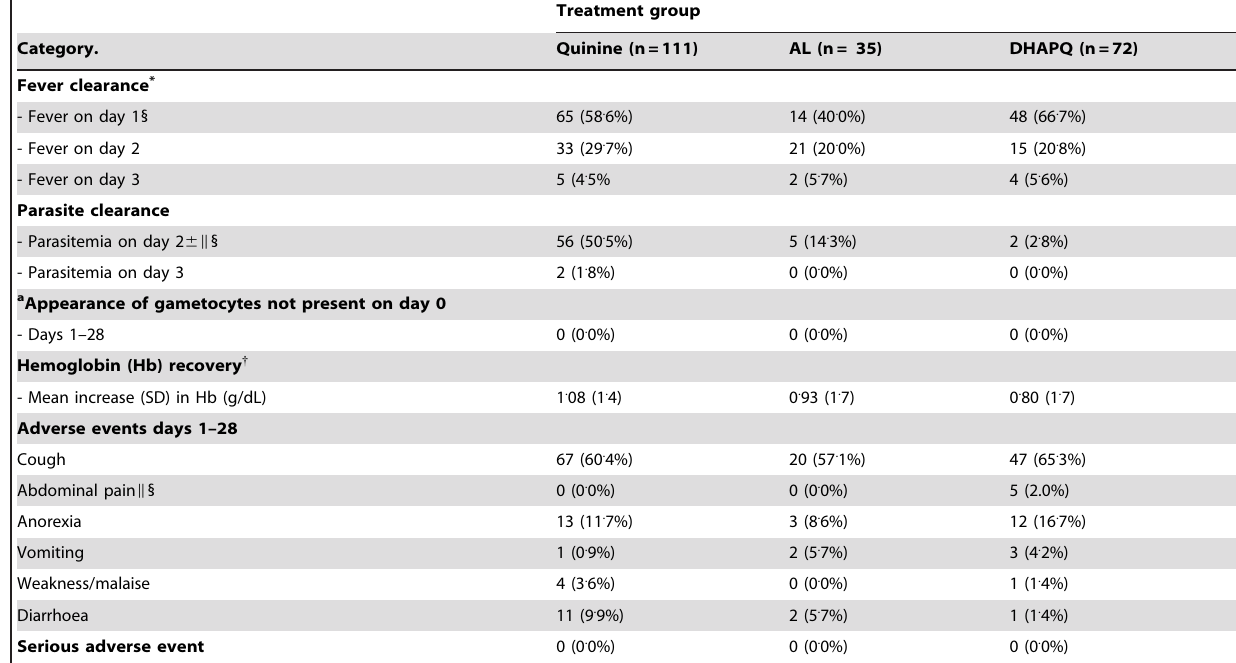
Table 4. Secondary